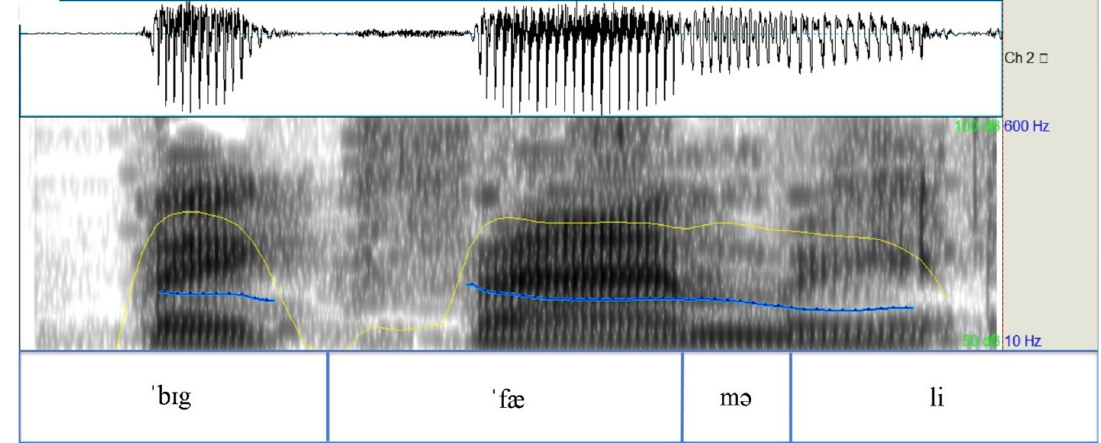
Figure 4 - Falling contour in the utterance produced by a HKE female speaker Note: blue curve indicates F0; yellow curve indicates intensity